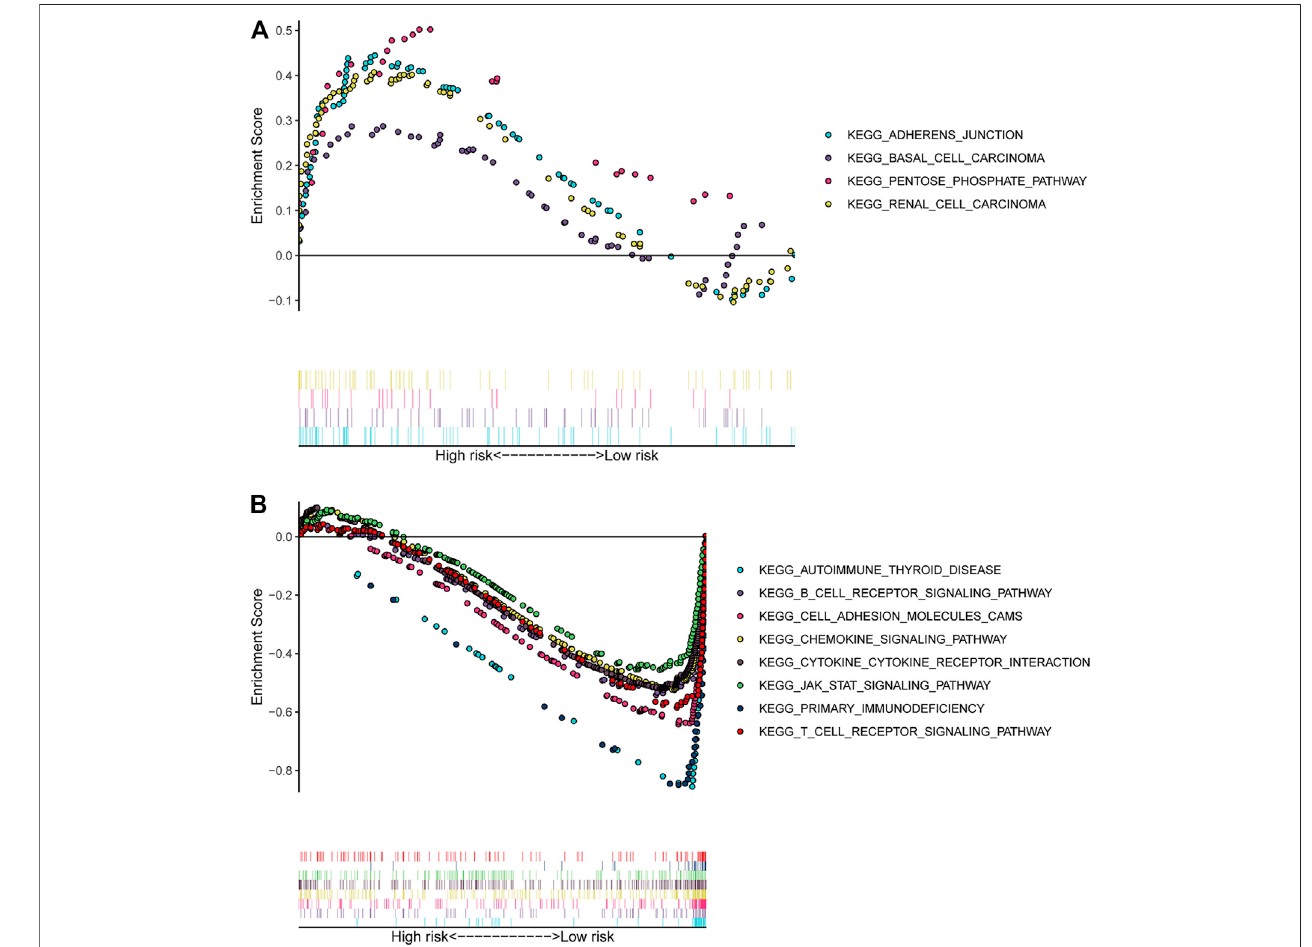
FIGURE 8 | GSEA analysis based on the 5-immune-gene signature. (A) Signi fi cantly enriched pathways in the high-risk group of CSCC; (B) signi fi cantly enriched pathways in the low-risk group of CSCC. The y -axis represented the enrichment score calculated by GSEA. Vertical bars under the x -axis represented the positions of genes in the given set. Positive enrichment scores denoted the pathways were signi fi cantly enriched in high-risk group, while negative enrichment scores denoted the pathways were signi fi cantly enriched in low-risk group. GSEA, gene set enrichment analysis.